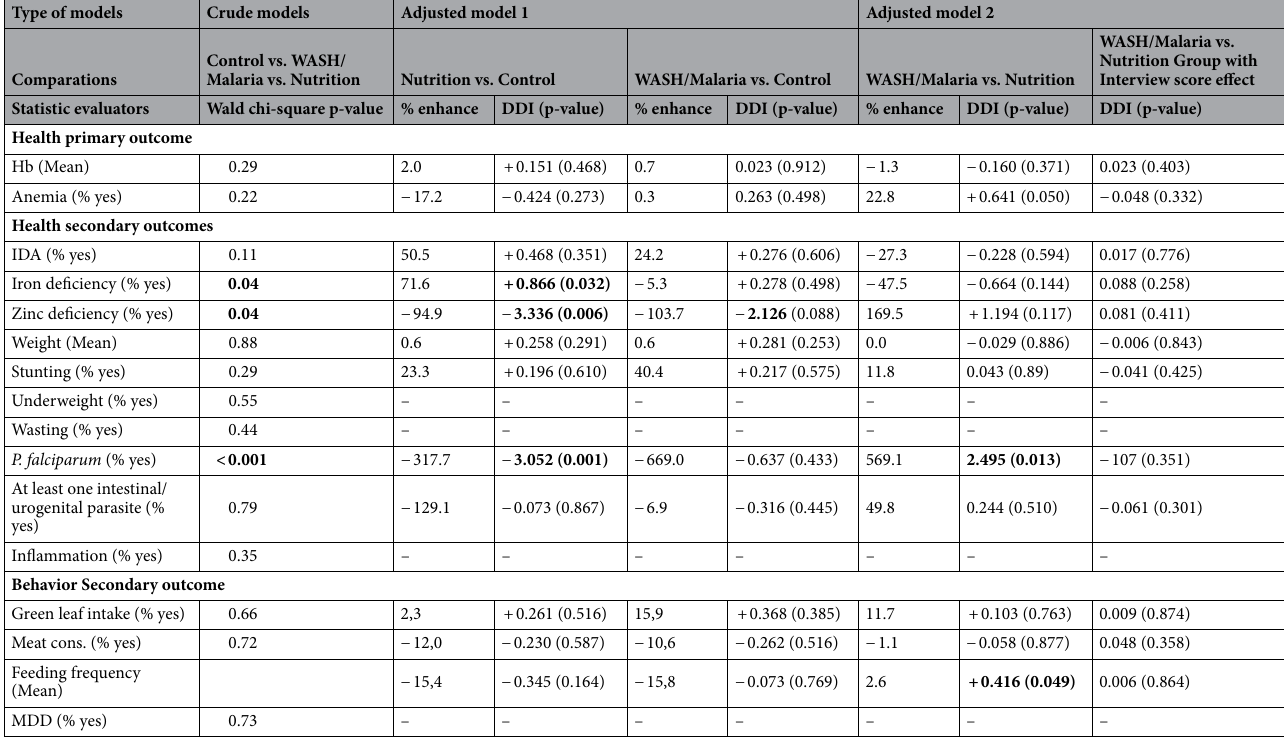
Table 1. Effectiveness of interventions in reducing anemia and their associated factors. Hb – Hemoglobin, IDA – Iron deficiency anemia. *difference-in-difference Wald chi-square, # Moderate-to-severe.